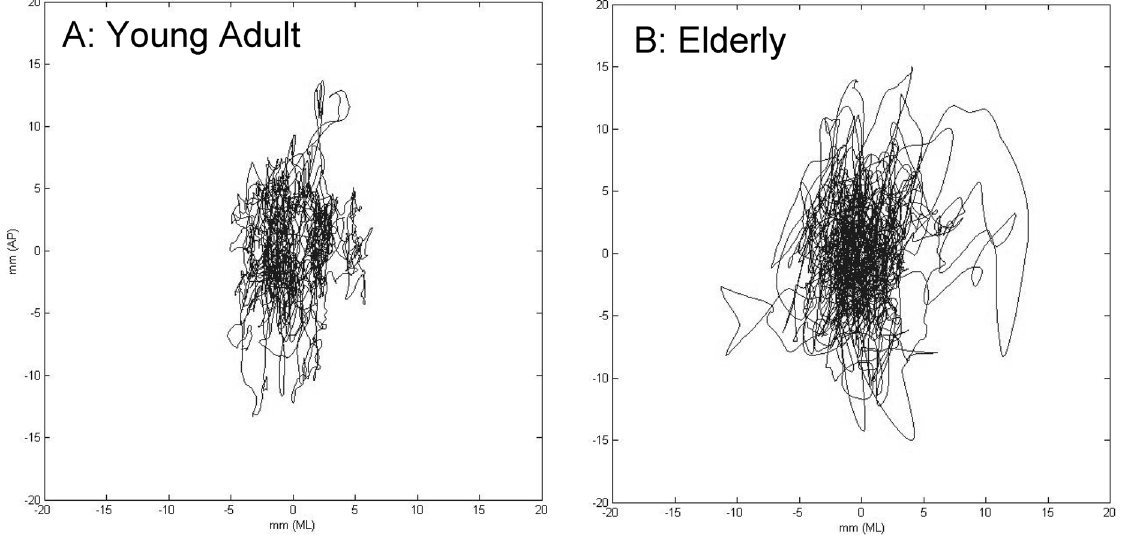
Figure 2. Stabilogram of a healthy young adult (A) and an elderly subject (B). The trace, collected over the four minute quiet-standing test period, represents movement of the center of pressure, in both the Medial-Lateral direction (side to side), and the Anterior-Posterior direction (front to back). Signs of poorer postural stability are evident in the aged subject, with a larger area of sway, as well as multiple excursions from center. As might be expected, with a longer path-length realized over the four-minute period in the elderly subject, peak sway velocities are also greater.